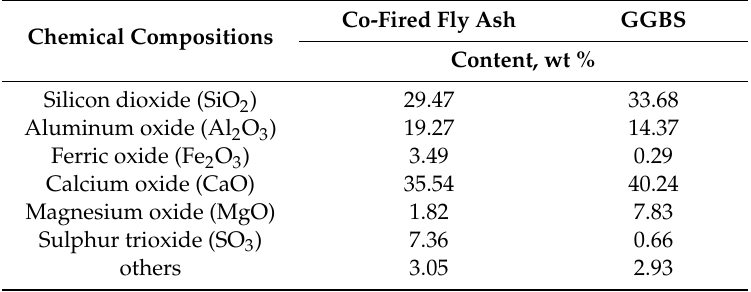
Table 1. Chemical compositions of co-fired fly ash and GGBS.